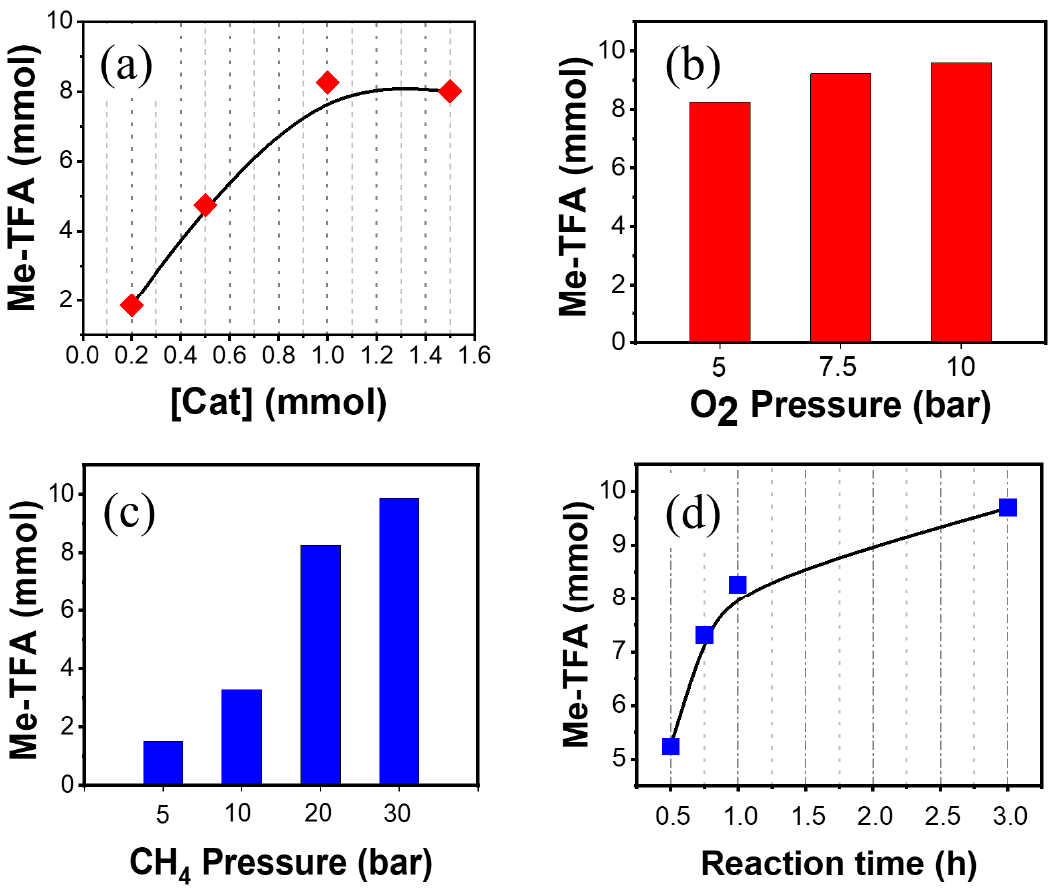
Figure 7. Effect of ( a ) catalyst concentration, ( b ) O 2 pressure, ( c ) CH 4 pressure, and ( d ) reaction time on the [Me 4 N] 2 CoCl 4 -catalyzed methane oxidation. Conditions: 1 mmol of catalyst, 5 bar of O 2 , 20 bar of methane, 5 g of TFAA, 25 g of HTFA, 180 °C, 1 h.